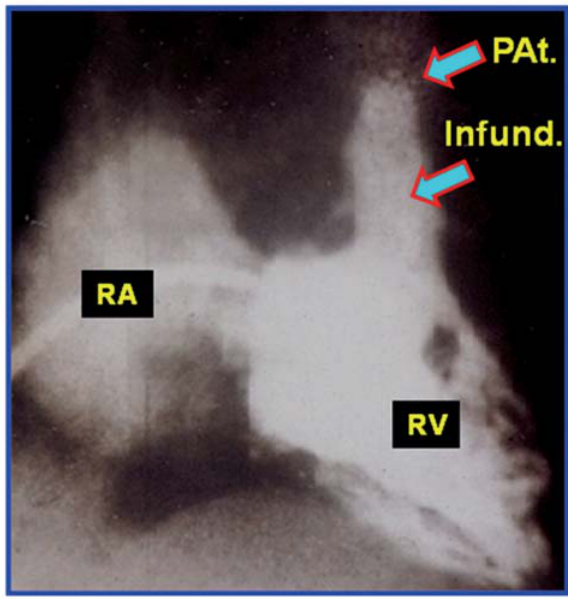
Fig. 1 - Angiographic study. Observed hypoplasic right ventricle, consisted by three segments: inlet, trabecular and infundibular portion. Observed too, pulmonary atresia and important tricuspid valve regurgitation. RA = right atrium; RV = right ventricle; Infund. = Infundibulum; PA. = pulmonary